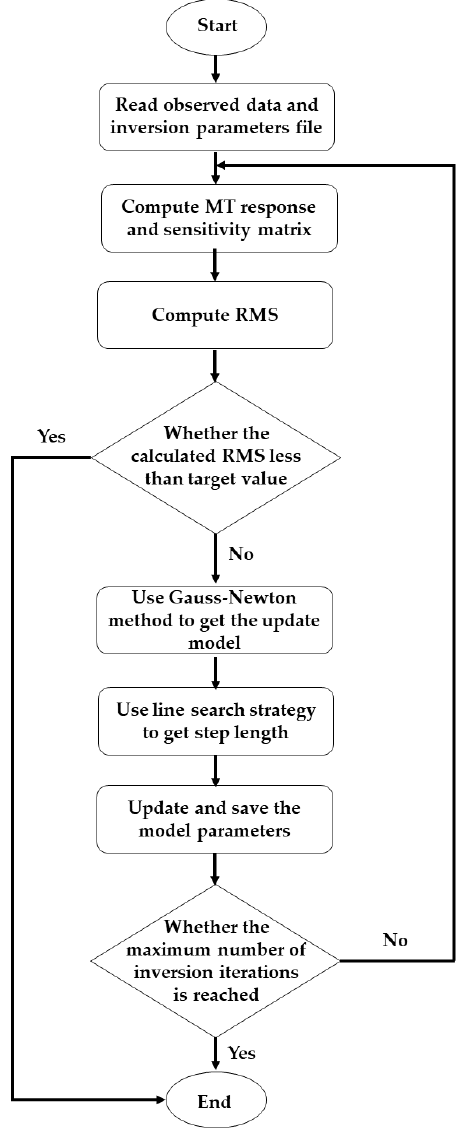
Figure 1. Workflow for 3-D magnetotelluric inversion with triaxial